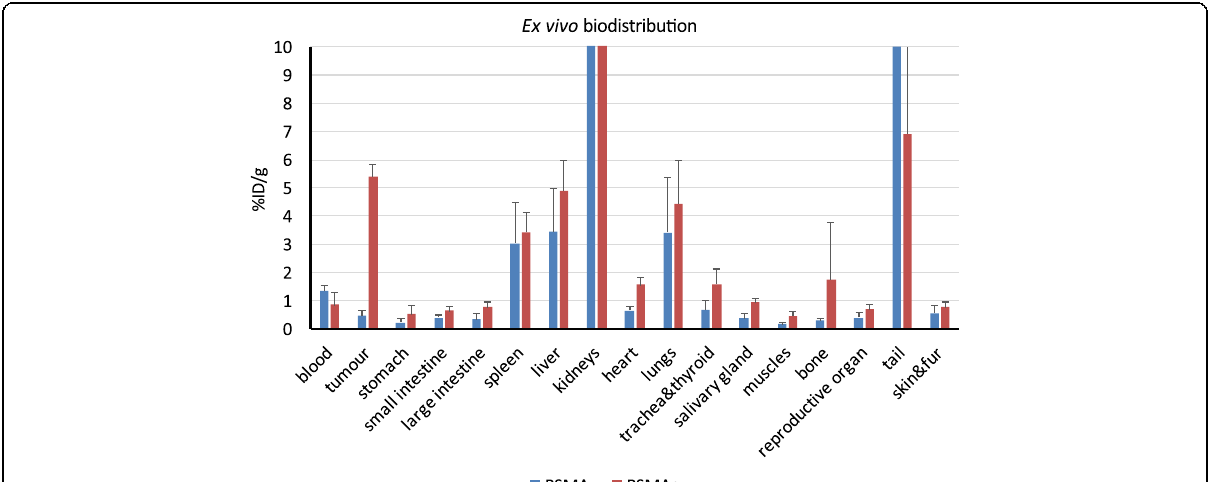
Fig. 5 Ex vivo biodistribution (%ID/g) of 68 Ga-THP-mal-J591c-scFv in SCID mice bearing DU145 parental or DU145-PSMA xenografts 60 – 90 min post-injection. Each bar represents a mean of 4 mice +